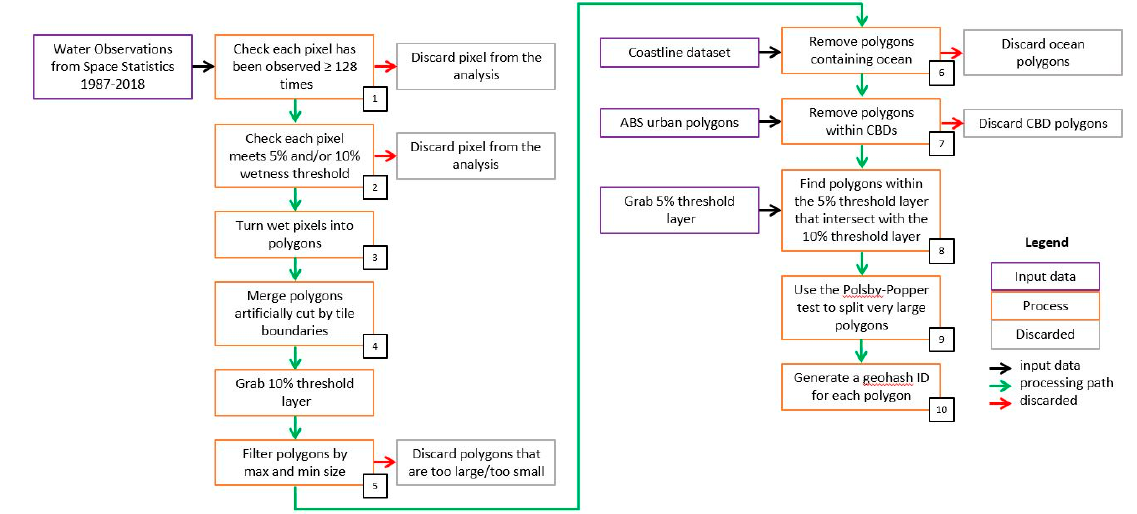
Figure 2. DEA Waterbodies workflow diagram. For a detailed description of the steps involved in producing the waterbody polygons, see Appendix A.